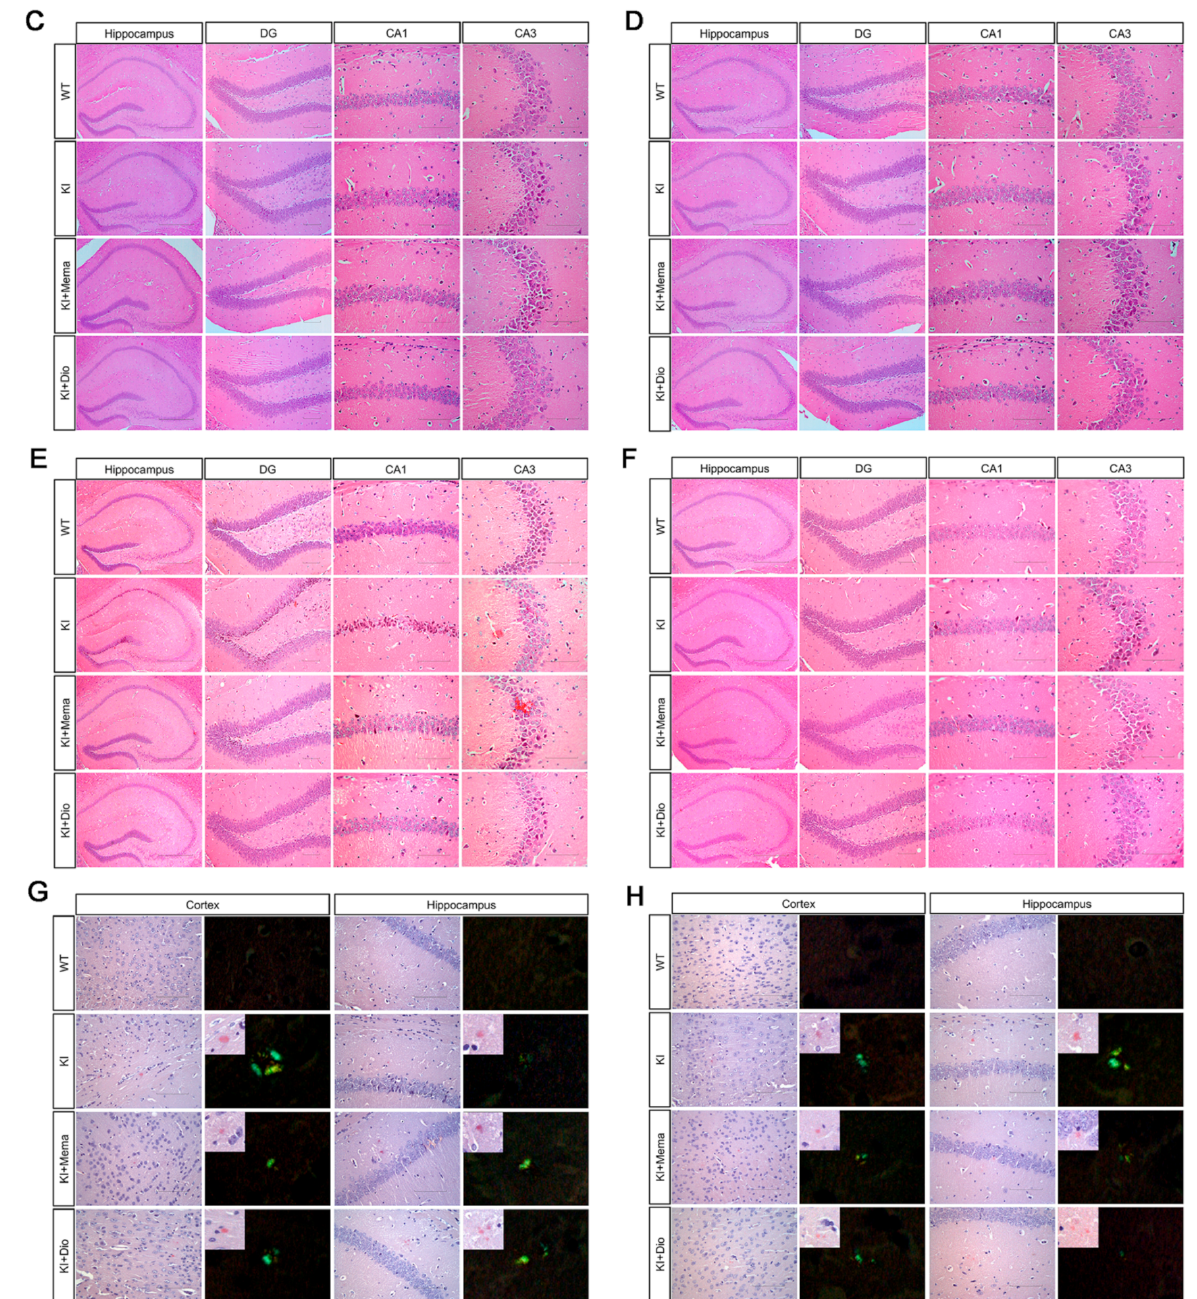
Figure 1. Body weight, brain index, and hippocampal morphology in young adult App NL-G-F mice. ( A ) Representative body weight changes from the first day of administration (1-month-old) to 150 days (6-month-old). Data are expressed as mean ± SEM. n = 12-24 mice/group. ▼ p < 0.05 compared with WT; ▼▼ p < 0.01 compared with WT. ■ p < 0.05 compared with App NL-G-F ; ■■ p < 0.01 compared with App NL-G-F ; ■■■ p < 0.001 compared with App NL-G-F . ◆ p < 0.05 compared with App NL-G-F ; ◆◆ p < 0.01 compared with App NL-G-F ; ◆◆◆ p < 0.001 compared with App NL-G-F ; ( B ) Representative ratio of brain weight to body weight in male and female mice at 3 and 6 months of age. Data are expressed as mean ± SEM. n = 6–8 mice/group. * p < 0.05 compared with WT; ( C – F ) Representative HE-staining in male and female mice at 3 and 6 months of age. Scale bars: 1 mm (panel Hippocampus) and 0.1 mm (panels DG, CA1, and CA3). n = 4–5 mice/group; ( G , H ) Representative CongoRed staining in male and female mice at 3 and 6 months of age. Scale bar: 0.1 mm. n = 4–5 mice/group; ( C ) 3-month-old male mice; ( D ) 3-month-old female mice; ( E , G ) 6-month-old male mice; ( F , H ) 6-month-old female